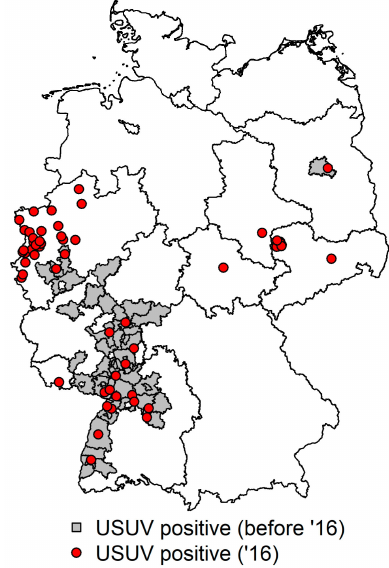
Figure 2. Detection of USUV in dead birds in 2016 (red dot = one USUV positive case/bird in 2016, grey areas = USUV positive areas before